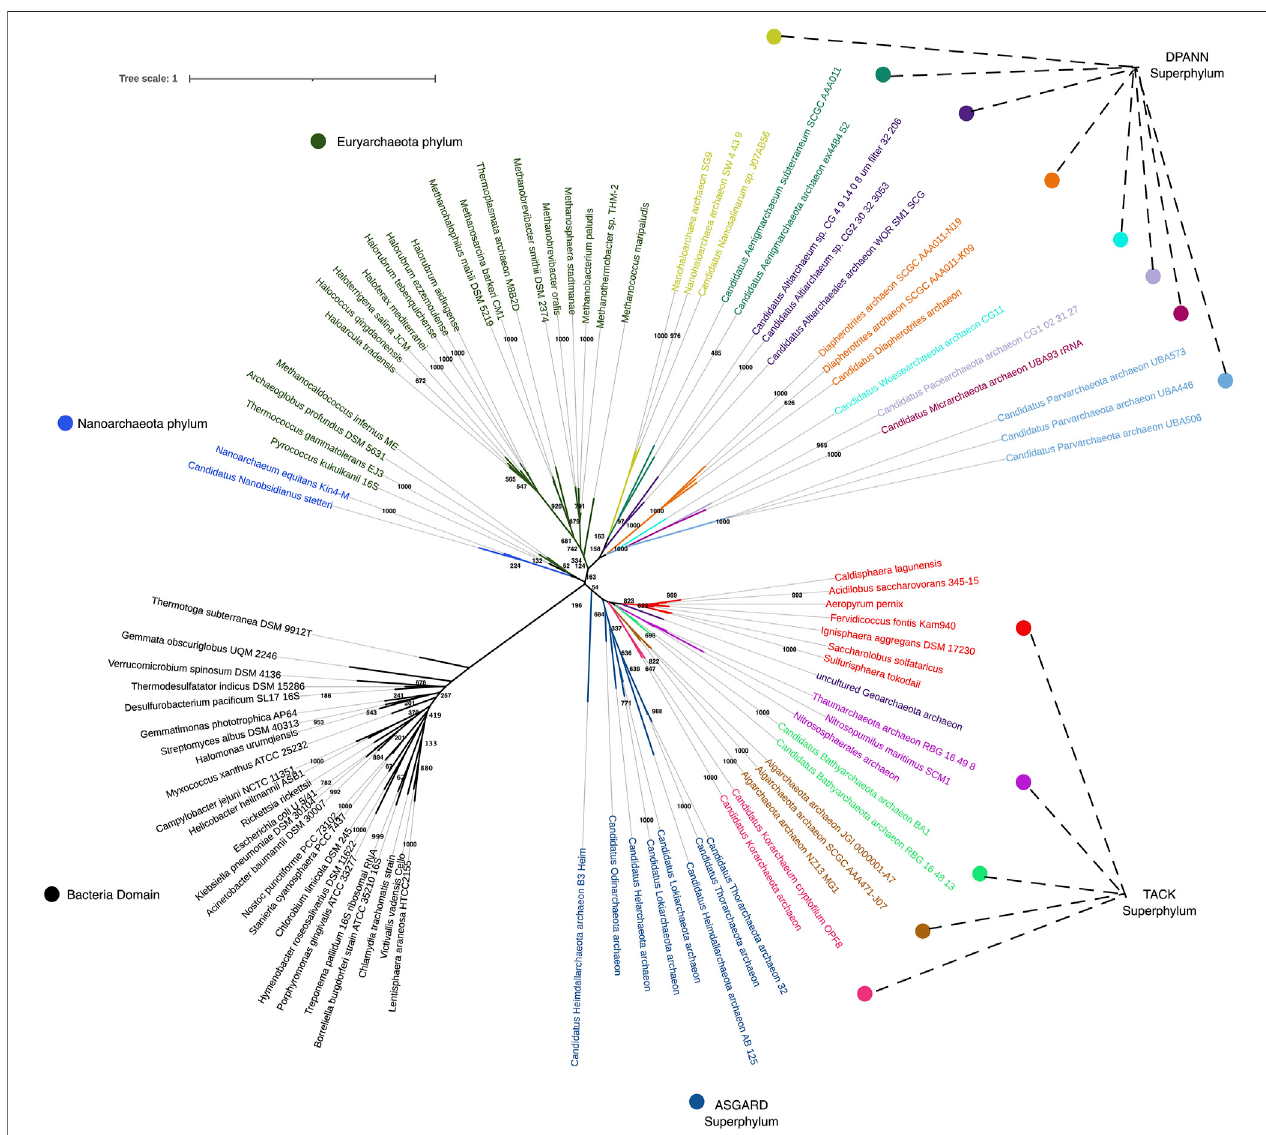
FIGURE 1 | Phylogenetic tree reconstruction encompassing 16S rRNA sequences from Archaea and Bacteria domains, using the Maximum Likelihood algorithm with GTR + (G + l) evolutionary model. Reliability of inferred tree was conducted with the bootstrap test of phylogeny using 1,000 bootstraps.